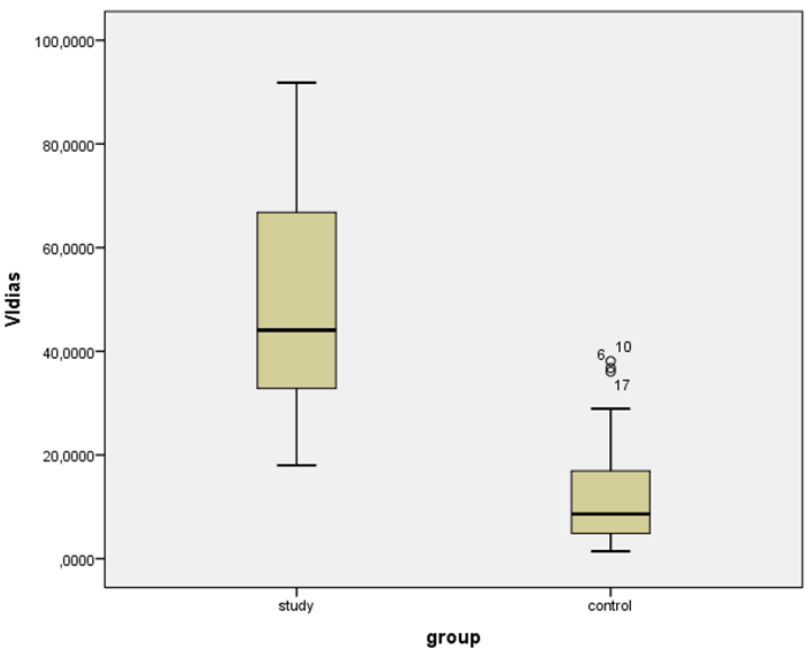
Figure 6. Box-plot for Vascularization Index (3D) in diastole (VIdias) for study and control group. Values of volumetric S/D indices and volumetric PI indices were statistically lower in ovarian tumors compared to normal ovaries: 1.096 vs. 1.794 and 0.092 vs. 0.558, respectively ( p < 0.001) (Table 1) (Figures 7 and